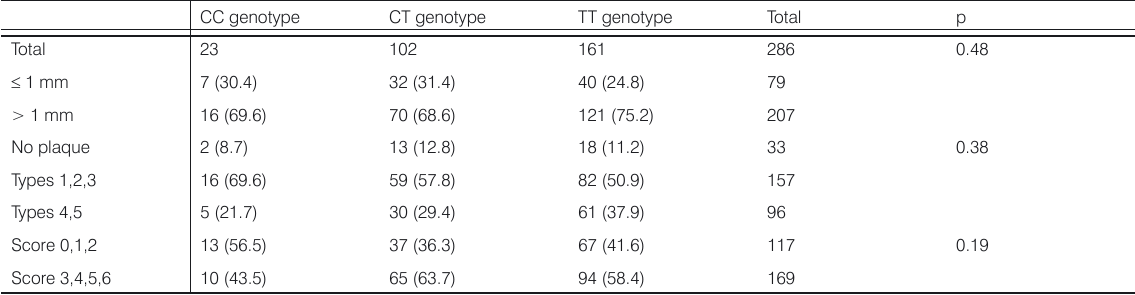
Table 3. Distribution of genotypes with respect to CIMT, plaque type and plaque